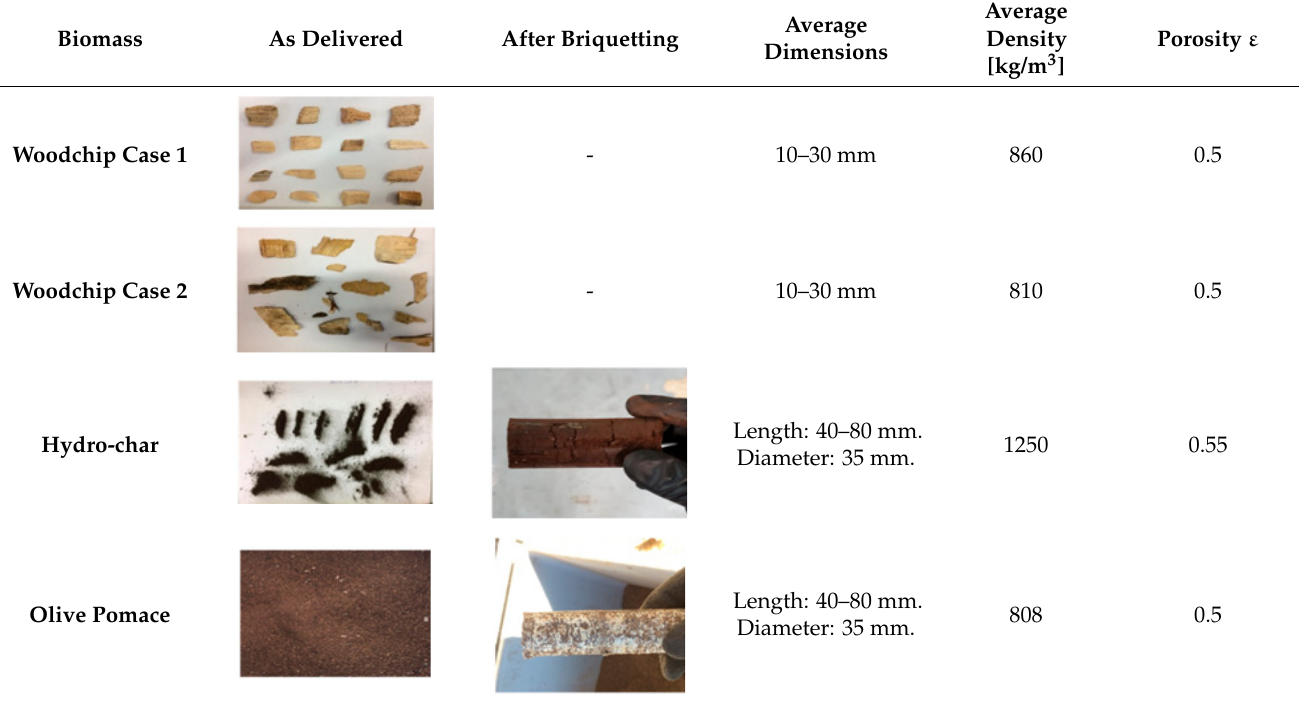
Average Dimensions